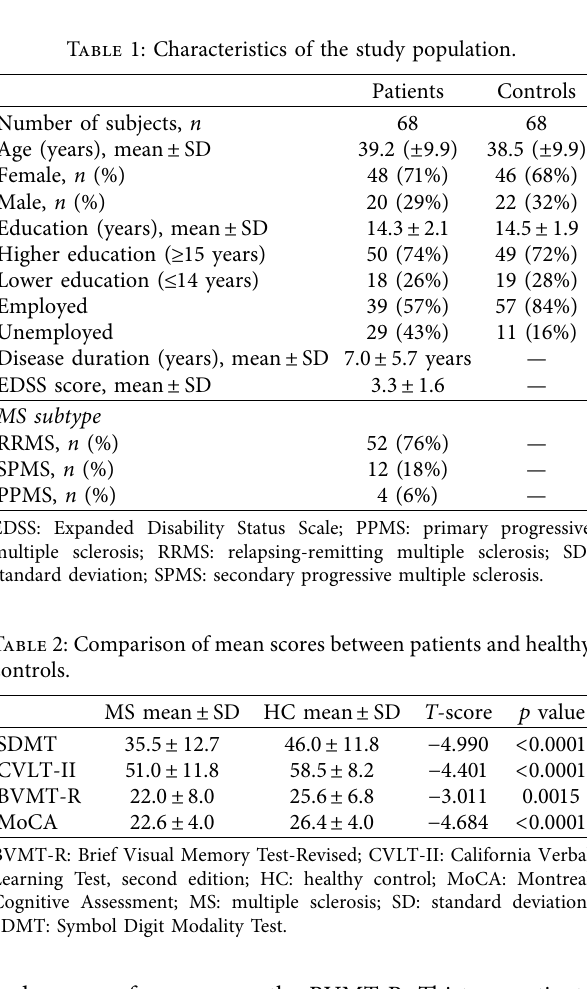
Table 1: Characteristics of the study population. Patients Controls